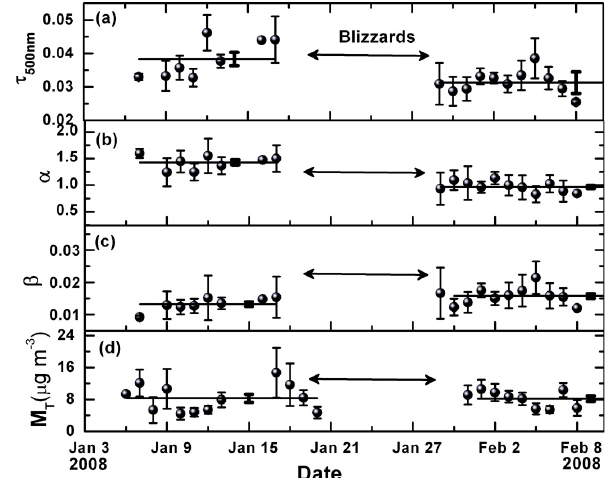
Fig. 9. Temporal variation of the daily mean values of the size in- dex ( ν) from α values (obtained from spectral values of columnar AOD) and those obtained from number size distribution retrieved from quartz crystal microbalance impactor.